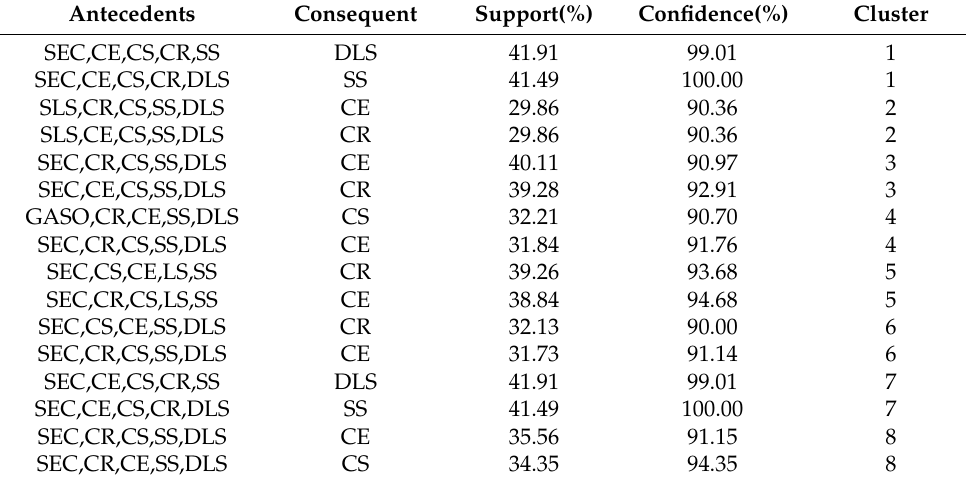
Table 7. Most relevant associate rules for each